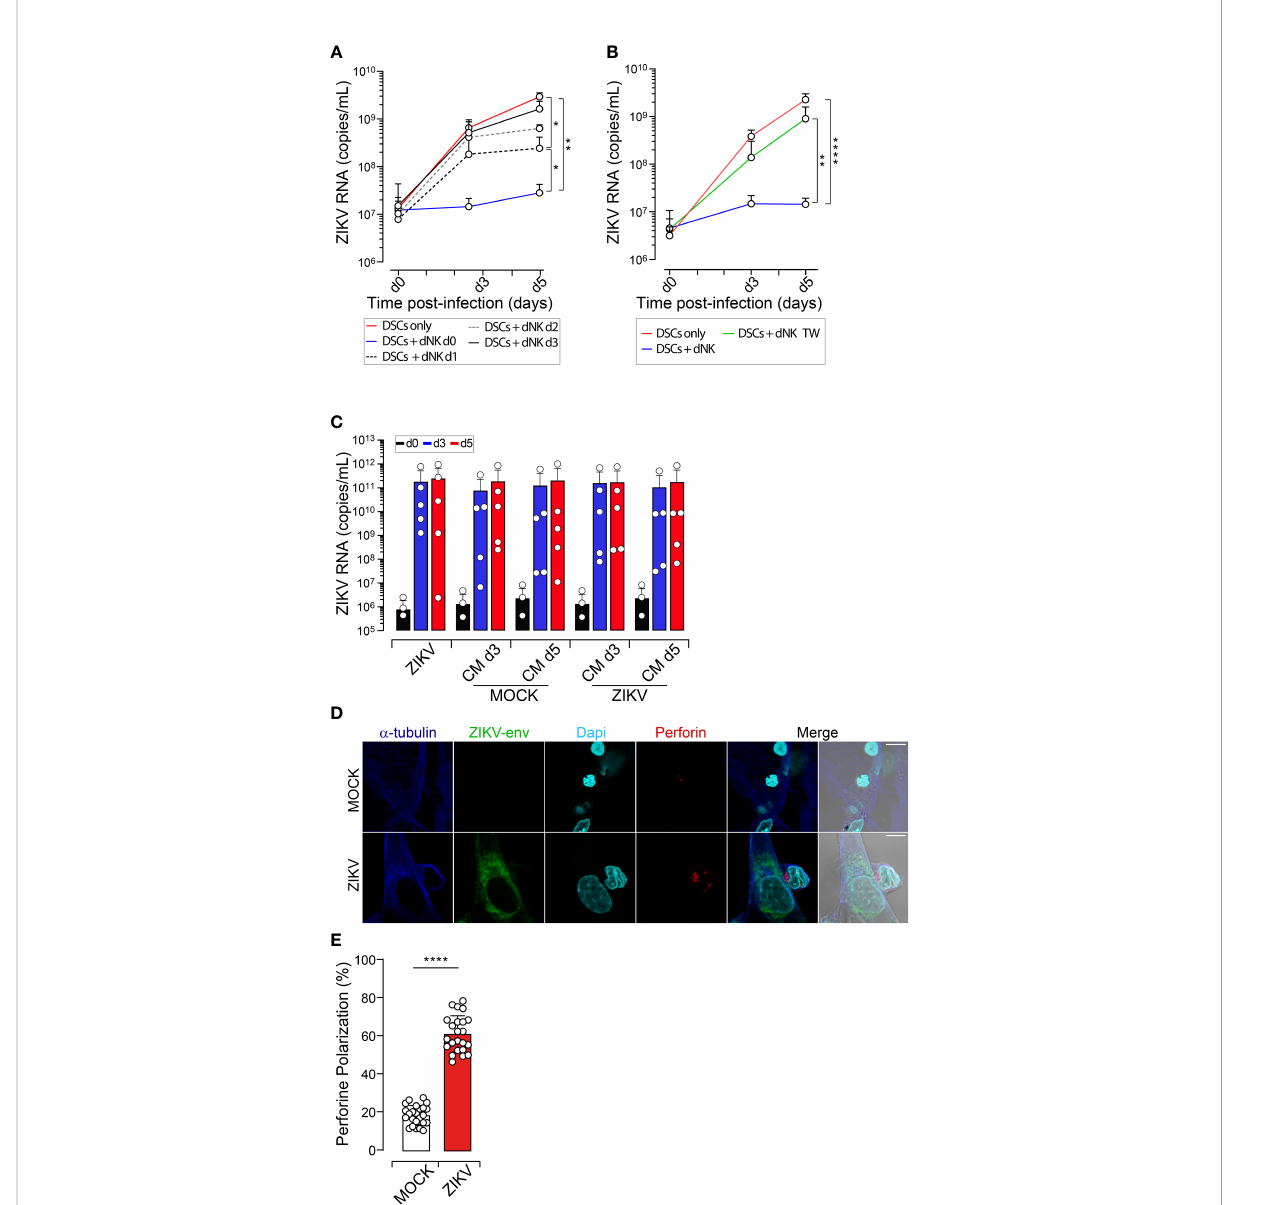
FIGURE 2 dNK Cells Ef fi ciently Control DSCs Infection. DSCs were infected with ZIKV at an MOI of 1 and co-cultured with autologous dNK cells at a ratio 1:5. (A-C) Viral loads are determined by qRT-PCR in cell-free culture supernatants, collected following the indicated time points d0, d3 and d5. (A) ZIKV-infected DSCs cultured alone (red line) or with autologous dNK cells added at day 0 (DSCs + dNK d0, blue line), day 1 (DSCs + dNK d1, dotted black line), day 2 (DSCs + dNK d2, dotted grey line) or day 3 (DSCs + dNK d3, solid black line) post-infection. (B) ZIKV-infected DSCs cultured alone (DSCs only, red), with autologous dNK cells in the same well (DSCs + dNK, blue) or separately by a 0.4µM porous membrane in transwell system (DSCs + dNK TW, green). (C) Fresh DSCs were infected with ZIKV (MOI 1) in the presence of UV-inactivated conditioned media collected from day 3 (CM d3) and day 5 (CM d5) co-cultures of dNK cells with uninfected (Mock) and ZIKV-infected DSCs (ZIKV). Histograms represent quanti fi cation of genome replication at day 0 (d0, black), day 3 (d3, blue) and day 5 (d5, red) post-viral challenge. Data sets are presented as mean values ± SEM from at least three independent donors. Statistical signi fi cance of differences was evaluated by repeated- measures analysis of variance with the Greenhouse and Geisser correction, and the Newman-Keuls post hoc test. * p <0.05, ** p <0.01, **** p <0.0001. (D) Uninfected and ZIKV-infected DSCs plated on glass coverslips incubated with autologous dNK cells for 20 min at 37°C. Representative confocal images of conjugates with maximum intensity projection are shown. Lytic granules containing perforin (red), ZIKV-env protein (green), a -tubulin (blue) and DAPI nuclei (cyan). Scale bar, 10 µm. (E) Percentage of conjugates showing polarized perforin containing granules to the NK cell IS. Results from 5 independent conjugations were averaged. Values represent mean values ± SEM. At least 300 conjugates were analyzed in each experiment (n=3). P values are computed using paired two-tailed Student ’ s t test,